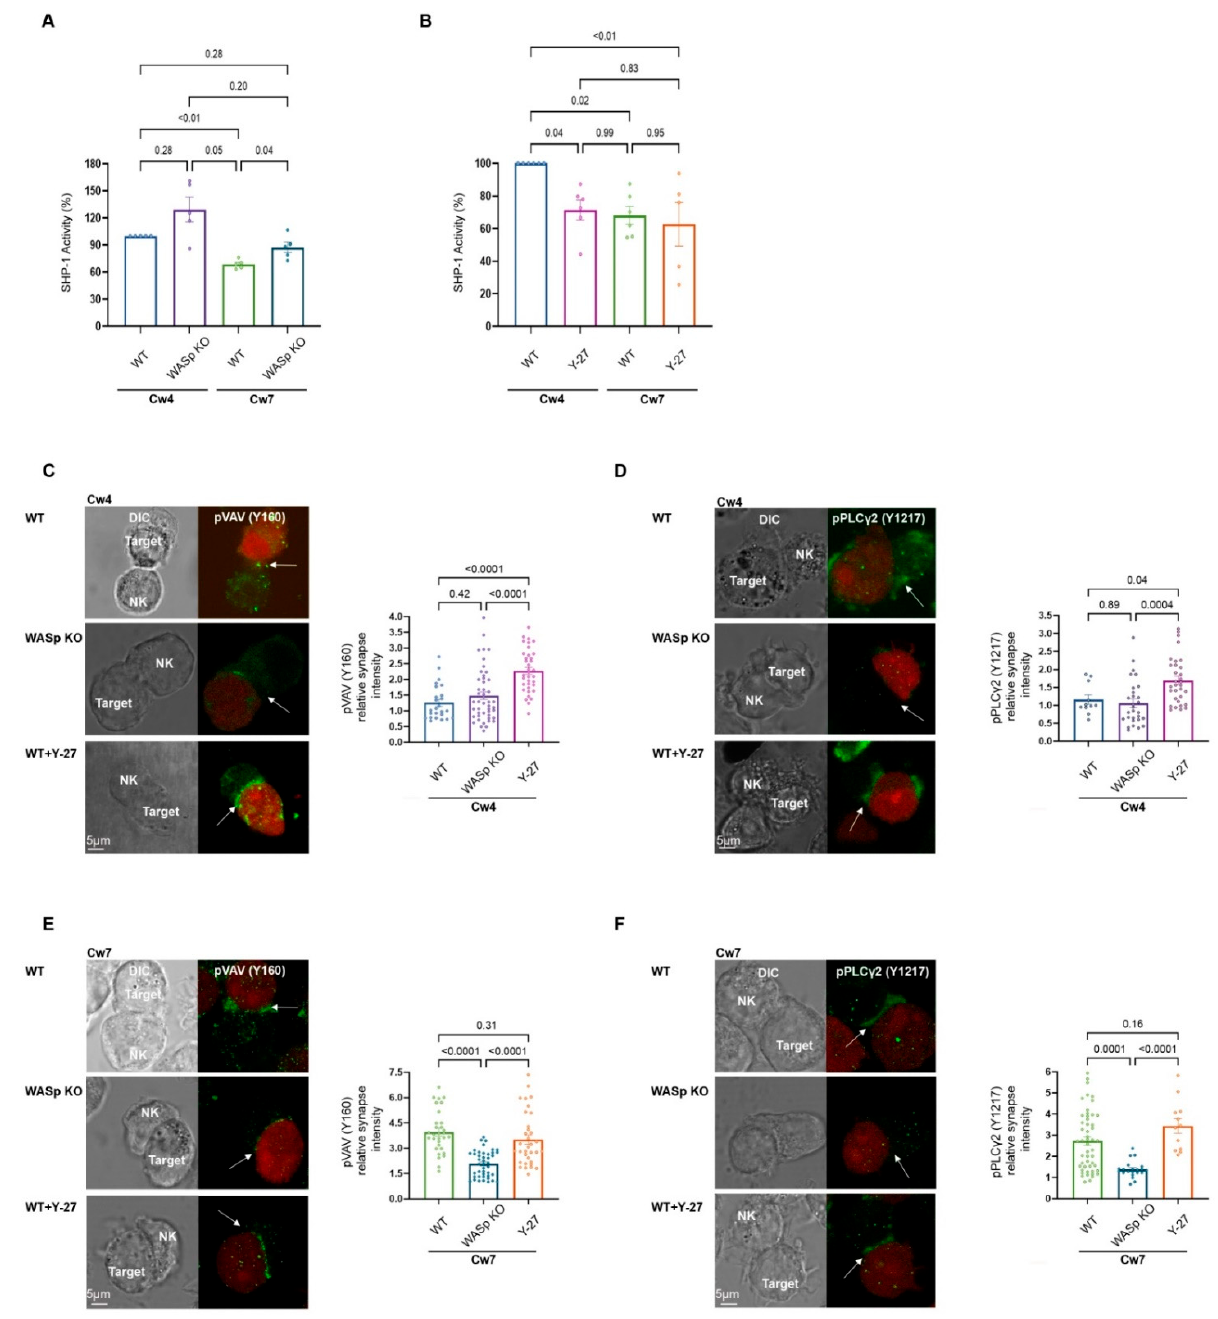
Figure 3. F-actin retrograde flow dictates SHP-1 catalytic activity. ( A , B ). YTS-2DL1 and WASp KO cells ( A ), or YTS-2DL1 treated with Y-27 ( B ), and were incubated at 37 °C with 221-Cw4 (inhibitory) or Cw7 (activating) target cells for 5 min, and SHP-1 activity was determined, as detailed in the Materials and Methods. Graphs summarize percentage of relative SHP-1 catalytic activity from five or four independent experiments, respectively. Statistical significance was calculated with one way ANOVA test, the data in the graph are represented as mean ± SEM. ( C – F ). YTS-2DL1 untreated, YTS-2DL1 treated with Y-27, or WASp KO cells and mCherry-expressing 221-Cw4 or 221-Cw7 target cells were co-incubated on slides at 37 °C followed by staining with ( C , E ) anti-pVAV1 (Y160) or ( D , F ) anti-pPLC γ 2 (Y1217) and secondary Alexa-488 Ab to determine the pVAV1 and pPLC γ 2 accumulation at the NKIS. The effector and target cells were distinguished by the expression levels of mCherry. Scale bars indicate 5 μ m. The NKIS site formed between YTS-2DL1 and target cells is indicated by white arrows. ( C ). Representative images and a representative graph summarizing the relative pVAV1 (Y160) synapse fluorescence intensities ( n = 25 for Cw4/YTS-2DL1; n = 36 for Cw4/YTS-2DL1 Y-27; n = 47 for Cw4/WASp KO). Statistical significance was calculated with one